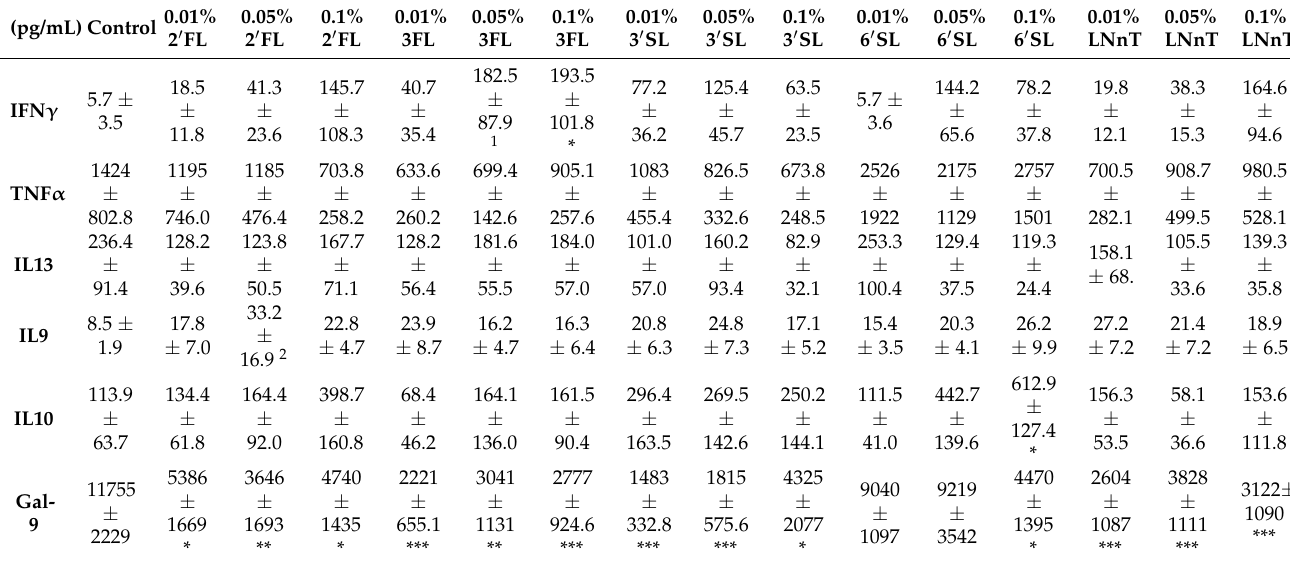
Table 2. Effects of HMOS on mediator secretion from nonactivated